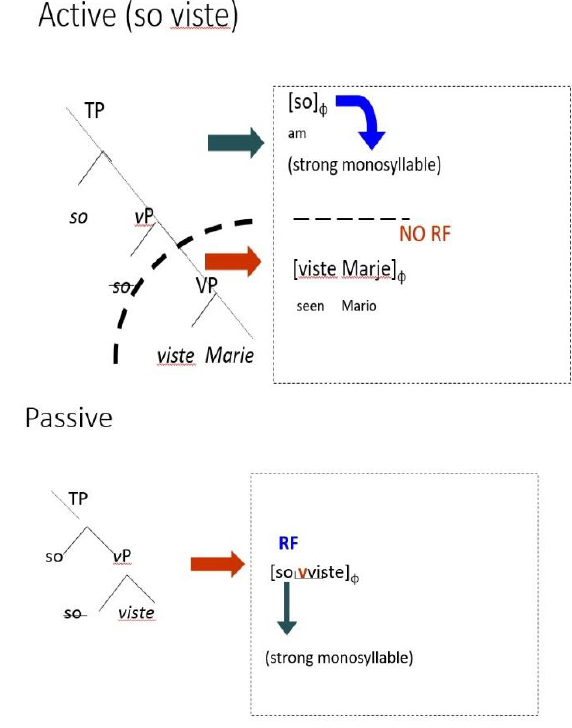
Figure 1. Active and passive in Eastern Abruzzese and phase-based